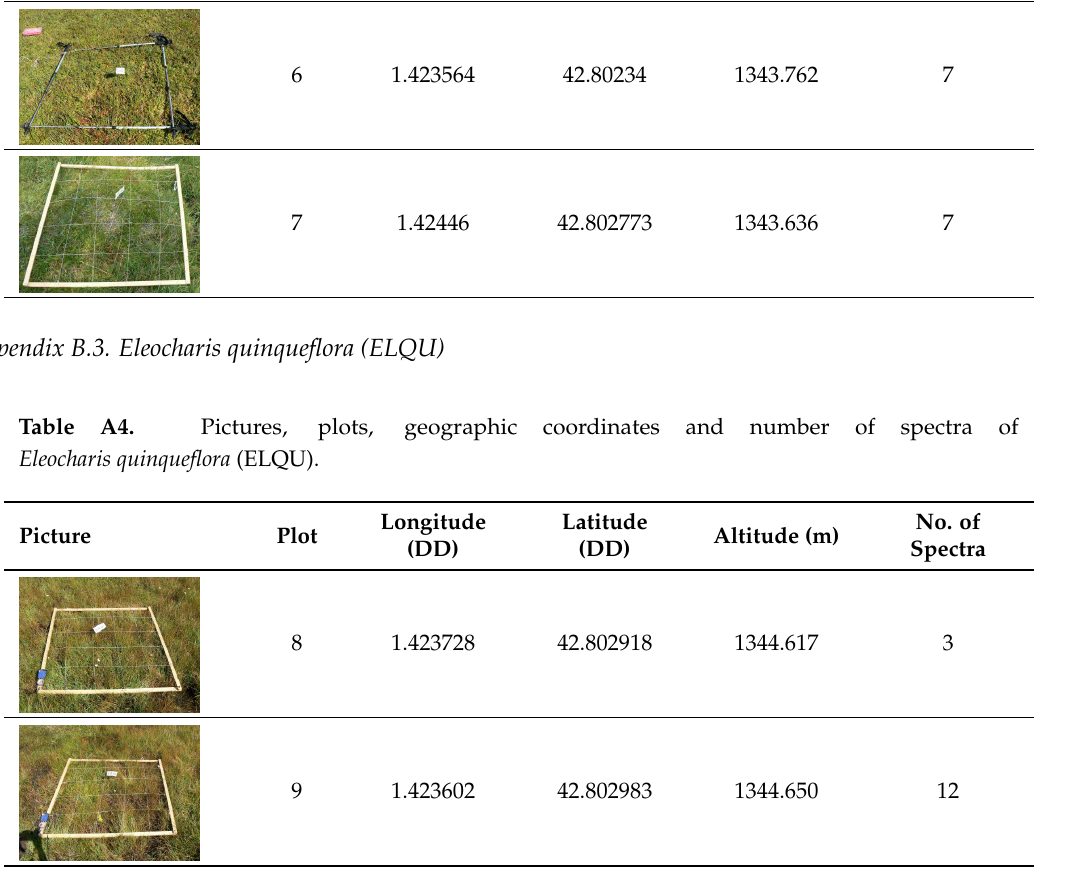
Figure A4. Mean reflectance ( µ ) and standard deviation ( σ ) of Calluna vulgaris (CAVU). Table A3. Pictures, plots, geographic coordinates and number of spectra of Calluna vulgaris (CAVU). Picture